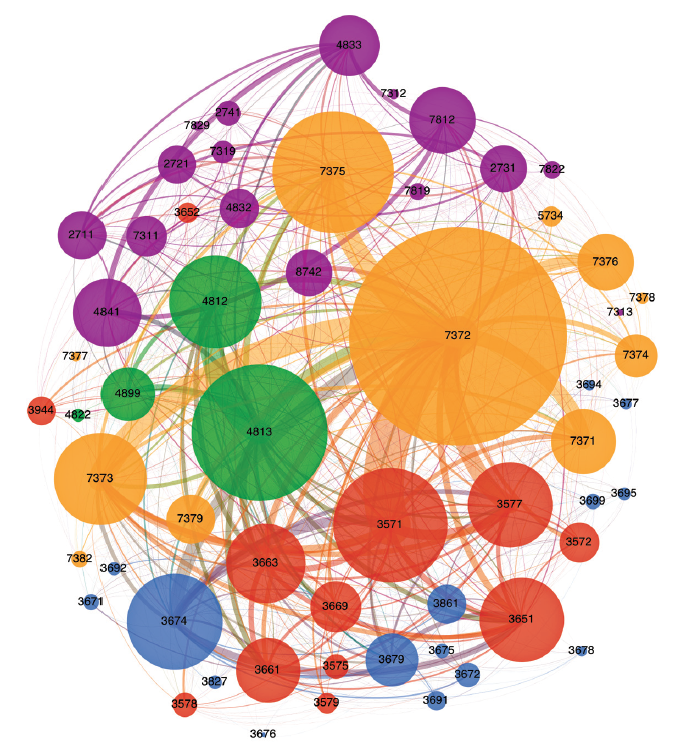
Figure 17. The force-directed network visualisation of ecosystem convergence. The nodes represent market segments and edges show inter-firm relationships between the segments. Image courtesy of Basole [76].